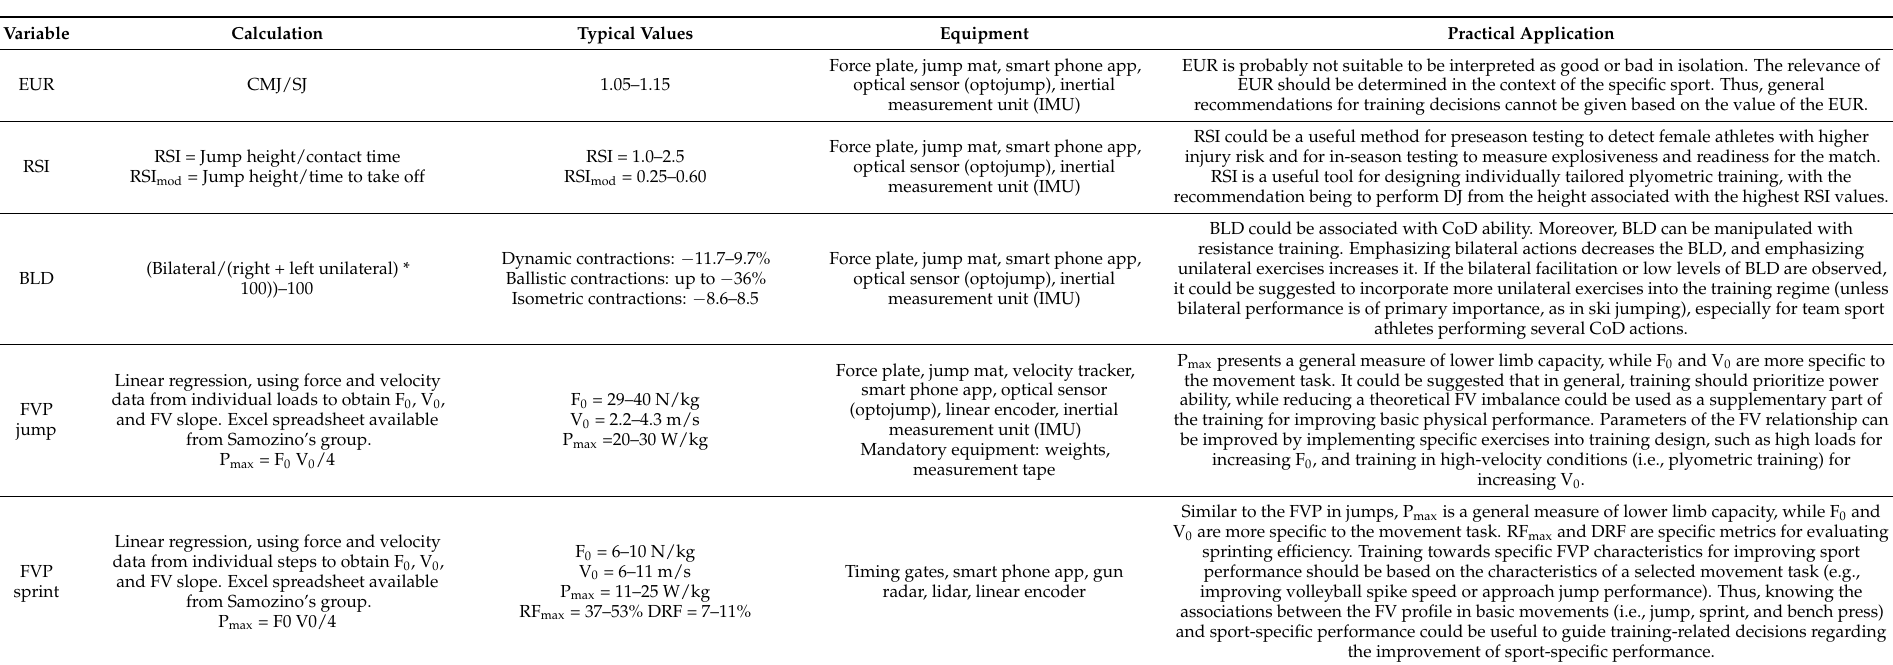
Table 1. Summary of the review